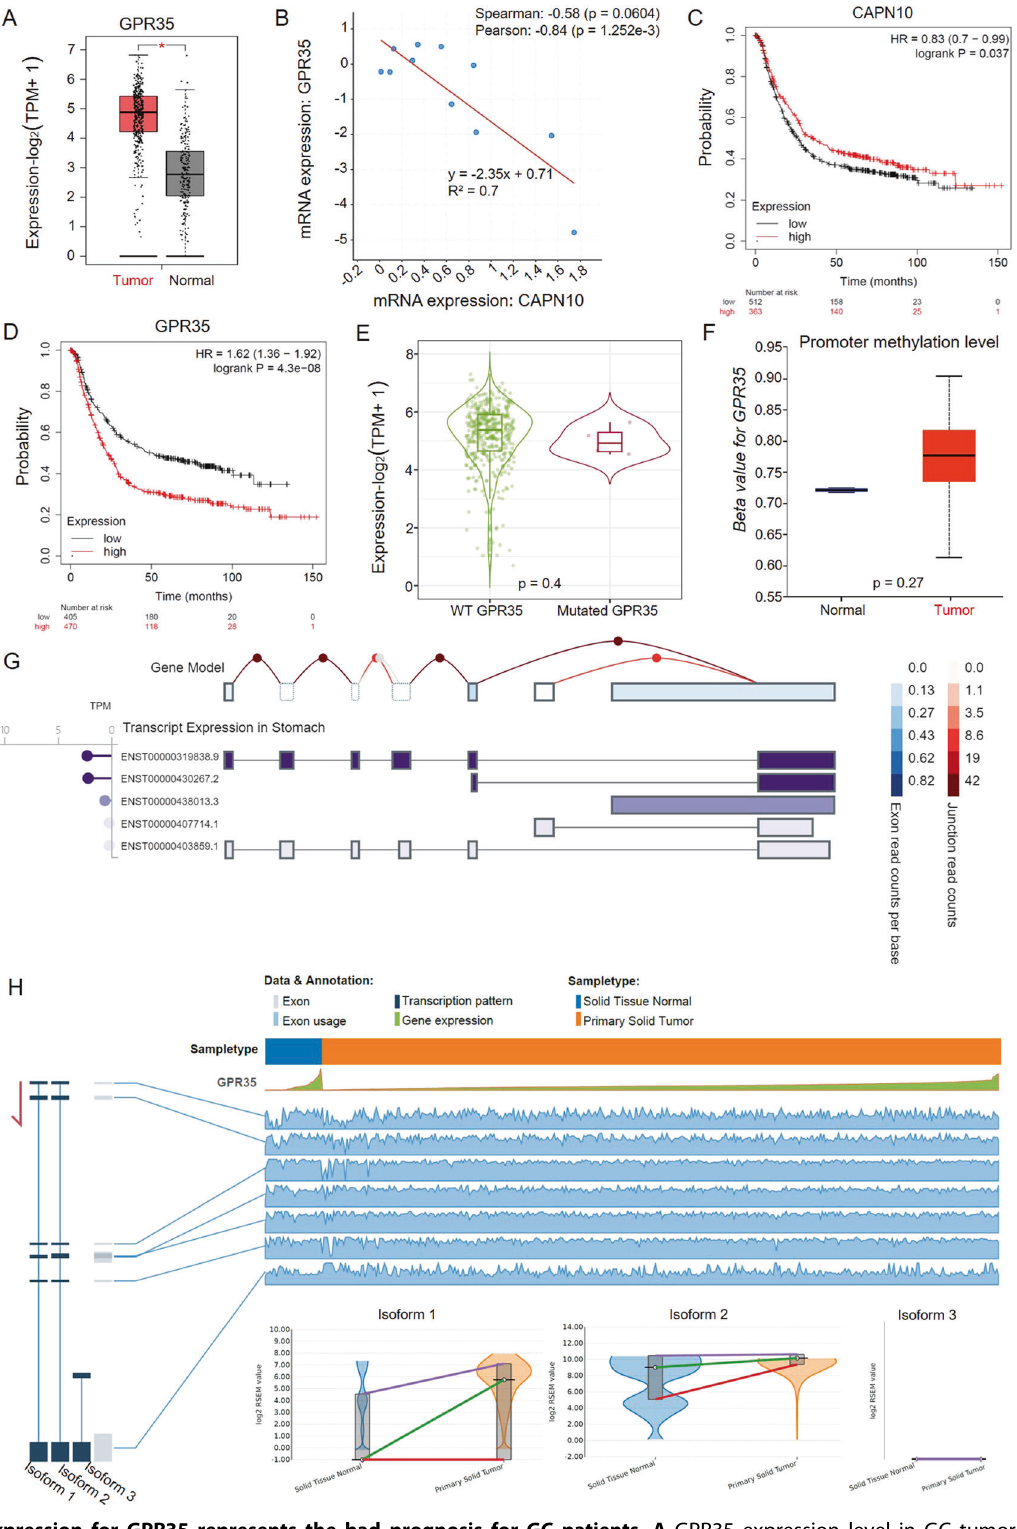
Fig. 3 High expression for GPR35 represents the bad prognosis for GC patients. A GPR35 expression level in GC tumor and matched normal tissues. B Relation between mRNA expression levels for GPR35 and CAPN10. C , D Kaplan – Meier curves depicting OS according to the expression patterns of CAPN10 ( C ) and GPR35 ( D ) in the GC cohort. P values were calculated with the log-rank test. E Differential GPR35 variations expression level in GC. P value was computed with the Mann – Whitney test. F Promoter methylation level of GPR35 in GC and normal tissues. P value was computed with the t -test. G Transcript expression of GPR35 in the stomach. H Alternative splicing events for GPR35 in GC and its corresponding normal solid tissues.